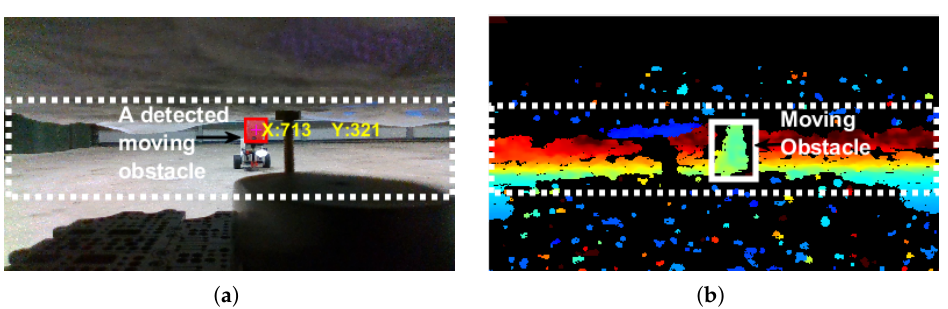
Figure 5. Experimental setup.